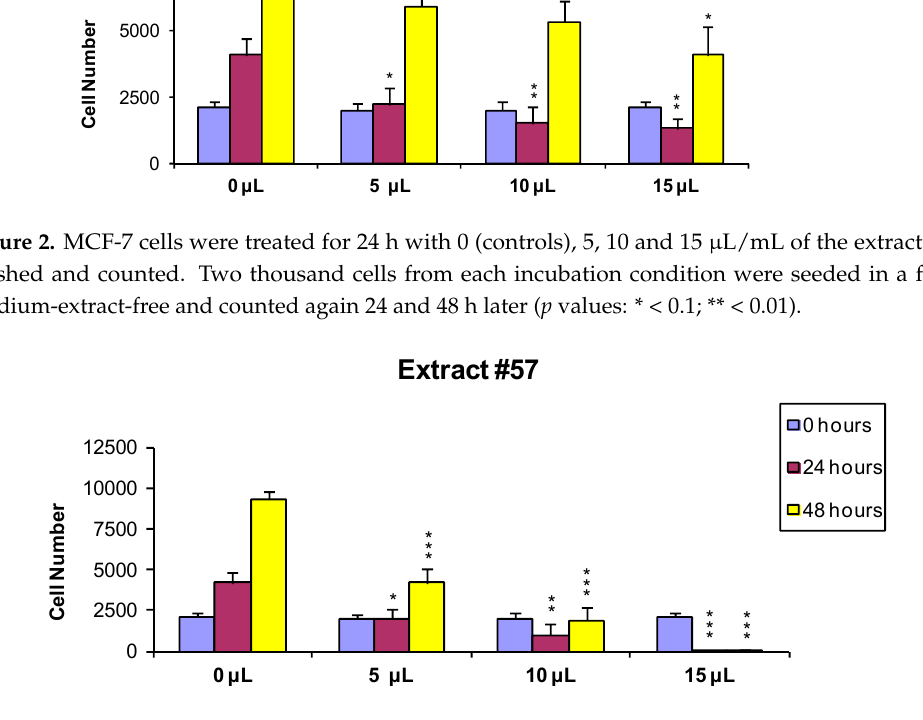
Figure 3. MCF-7 cells were treated for 24 h with 0 (controls), 5, 10 and 15 µ L/mL of the extract #57, washed and counted. Two thousand cells from each incubation condition were seeded in a fresh medium-extract-free and counted again 24 and 48 h later ( p values: * < 0.1; ** < 0.01; *** < 0.001).